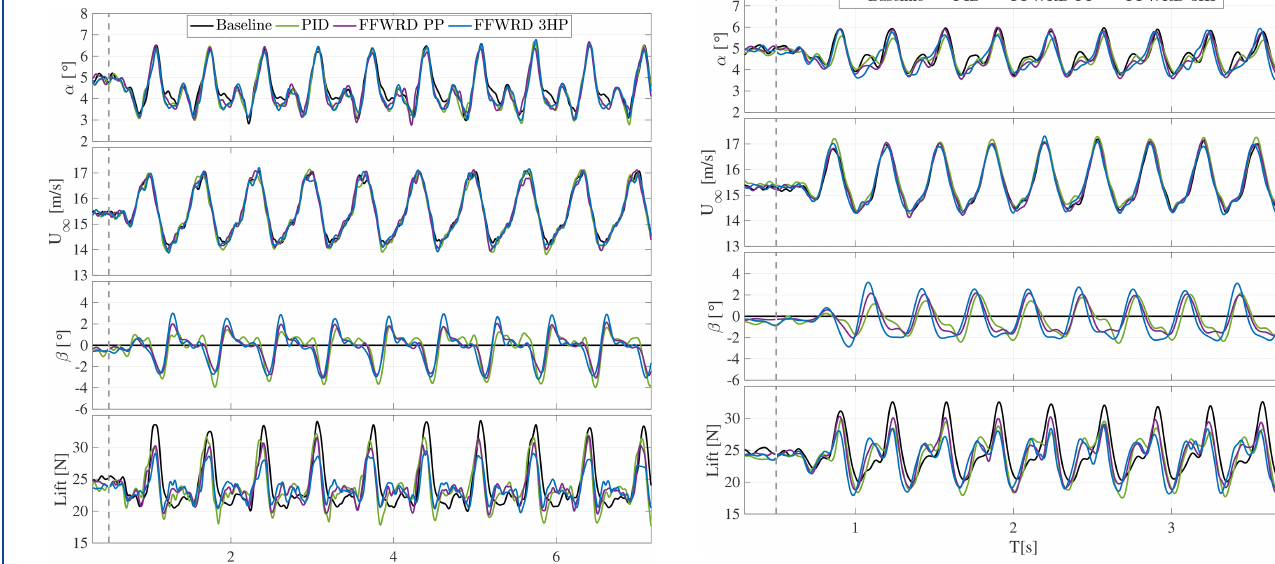
Figure D3. Time series of angle of attack and velocity variation, flap motion, and resulting lift amplitude at a reduced frequency of k = 0 . 192.